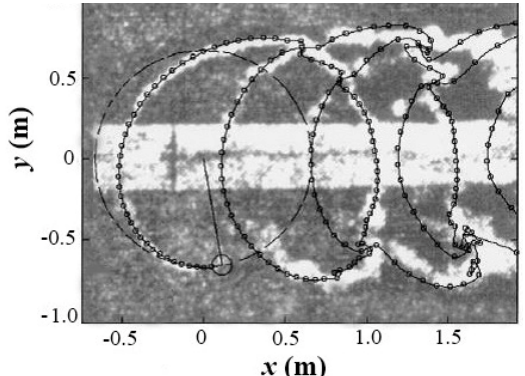
Figure 4. Shed vortex central path by experimental visualization and FEVDTM prediction (Turbine A, λ = 5, Z = 1).